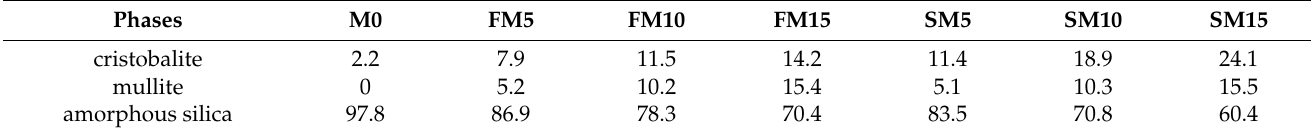
Figure 2. XRD patterns of the ceramic cores with different contents of ( a ) fused and ( b ) sintered mullite powders. Table 3. Mass fraction (wt.%) of the phases in different ceramic